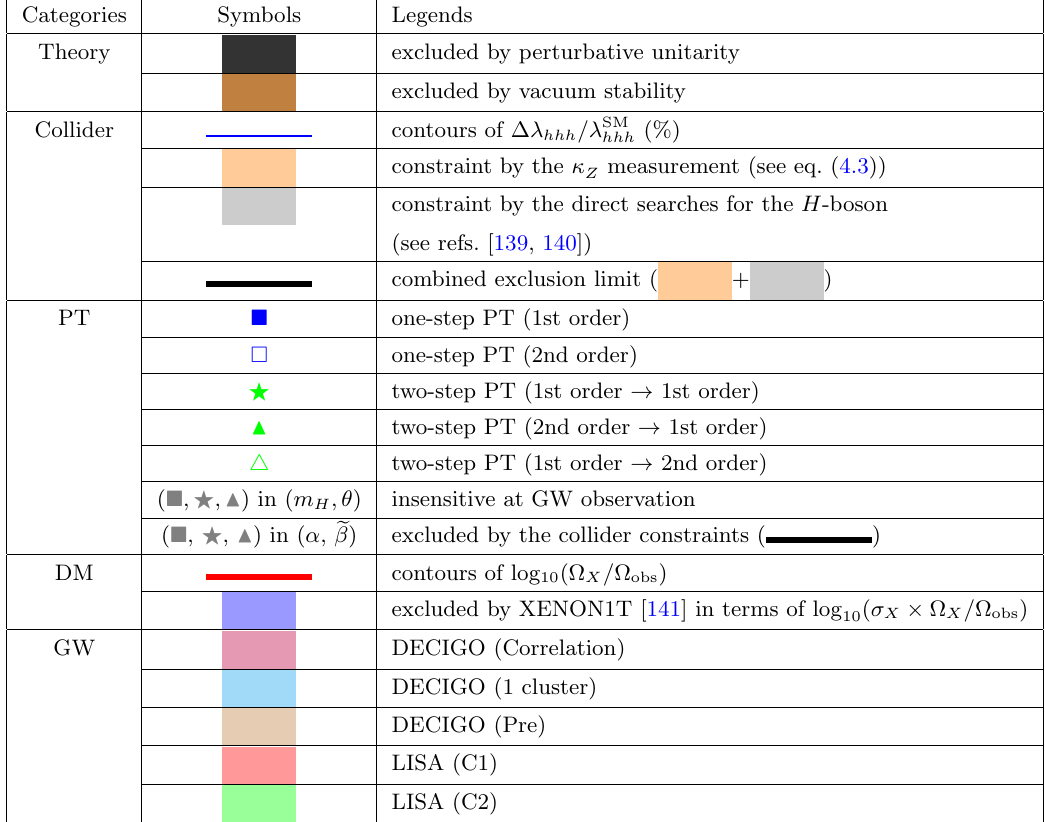
( ) denotes that there are (no) regions (cid:13) △ (cid:13)